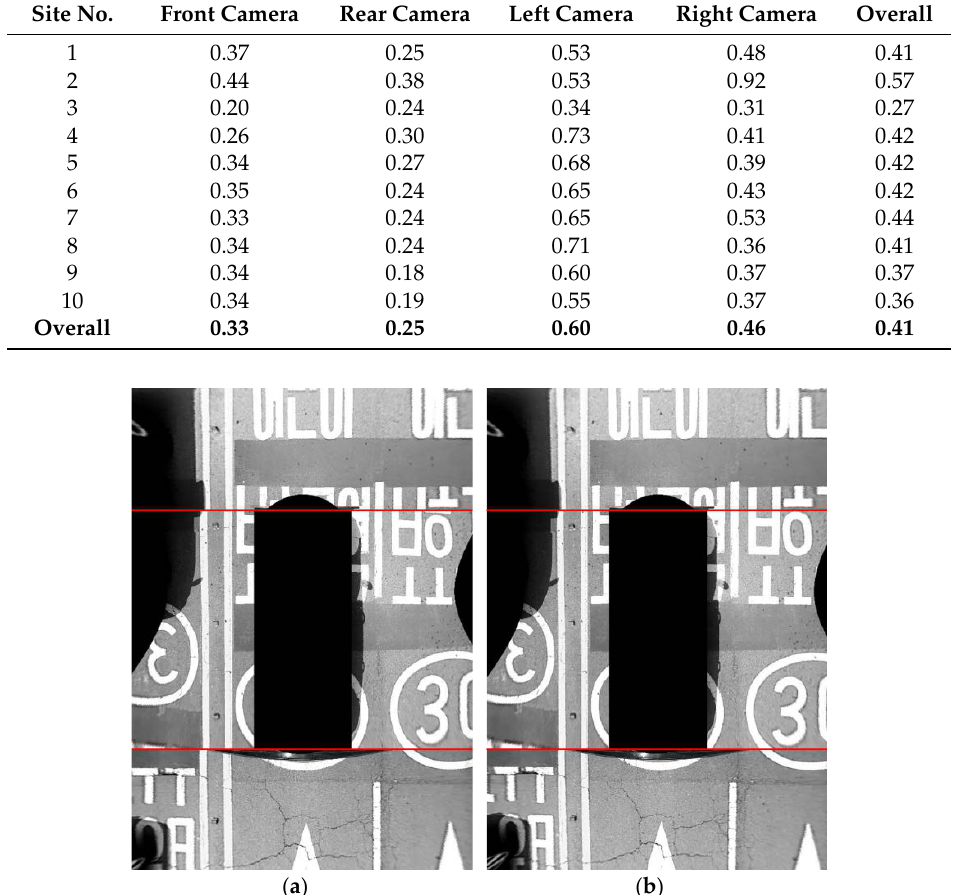
Figure 13. Resulting AVM images ( a ) without the parameter co-refinement, and ( b ) with the parameter co-refinement. Red lines indicate image boundaries.